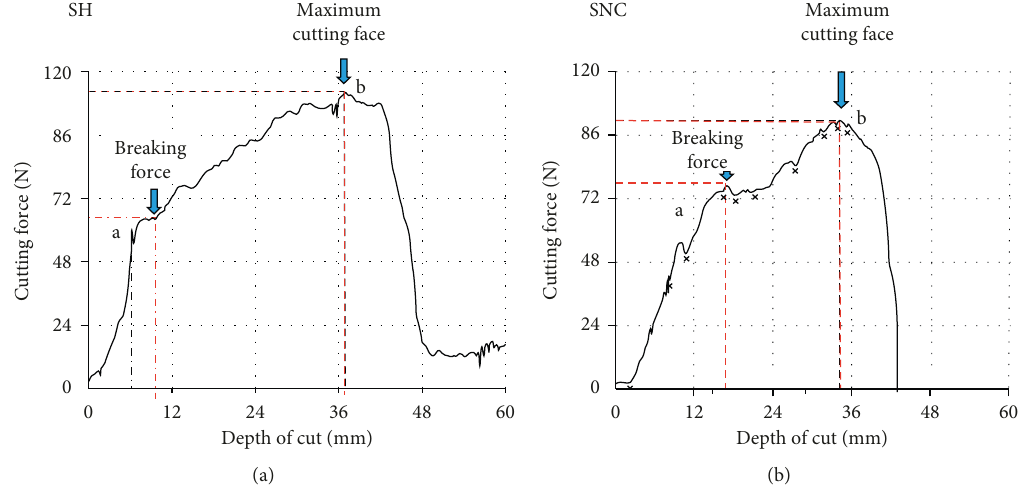
Figure 2: Cutting curves of SH and SNC obtained with the Wagner–Bratzler blade